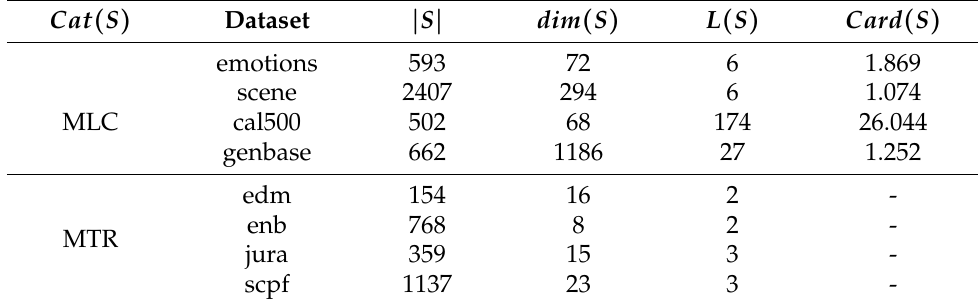
Table 1. Characteristics of